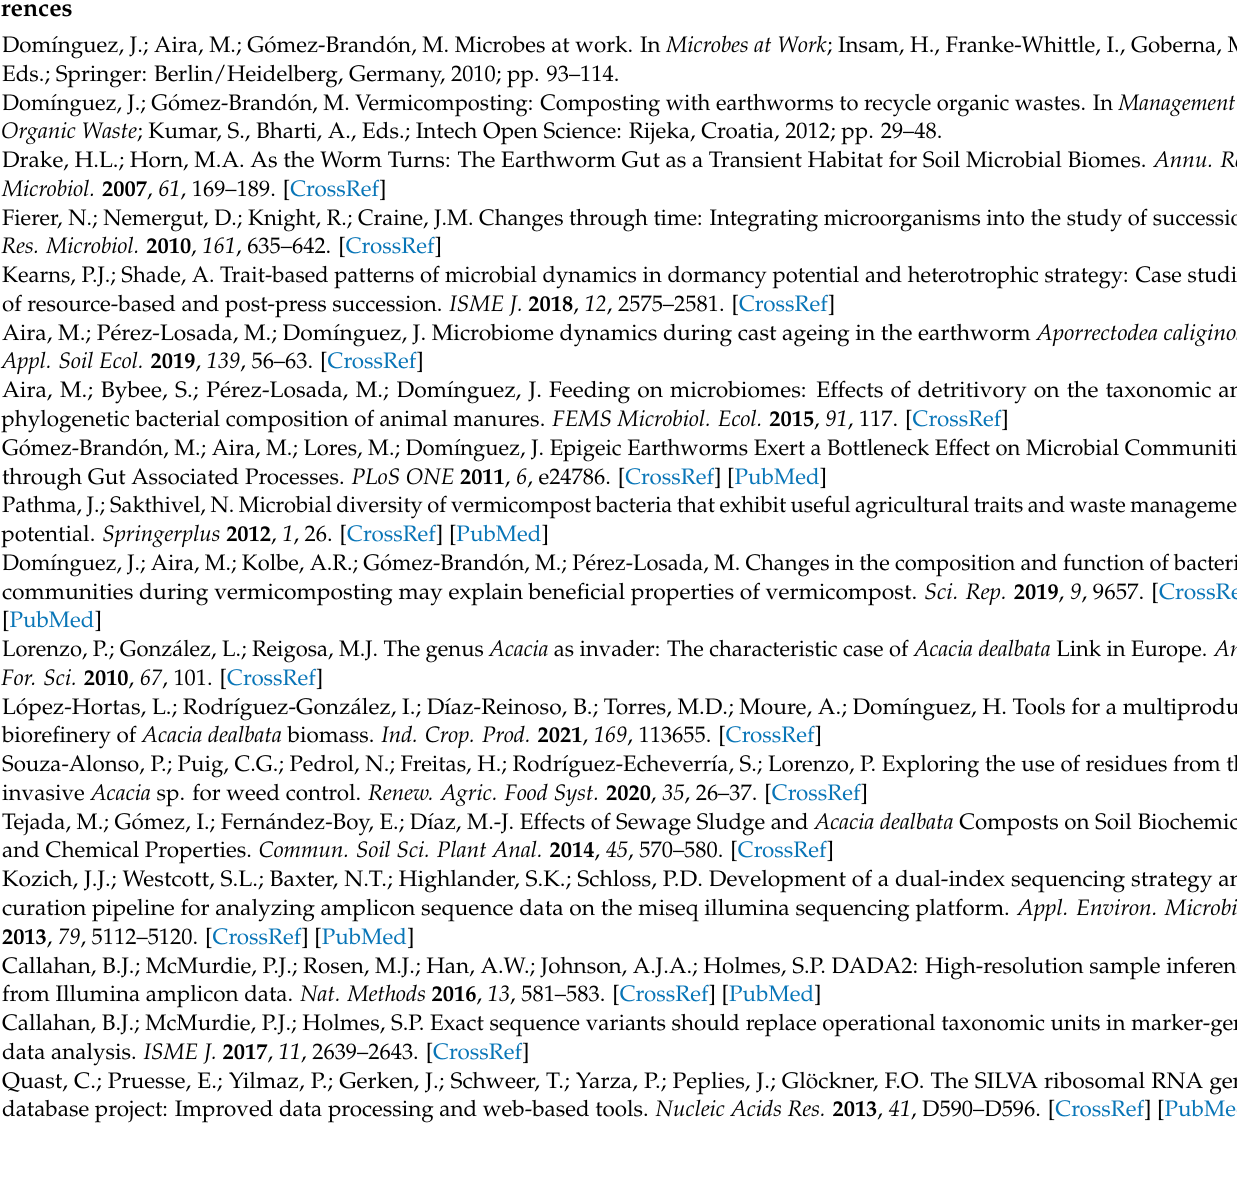
FDR corrected). Table S1: Differential abundance in bacterial taxa during vermicomposting of silver wattle ( Acacia dealbata ) were analyzed using negative binomial models as implemented in the package